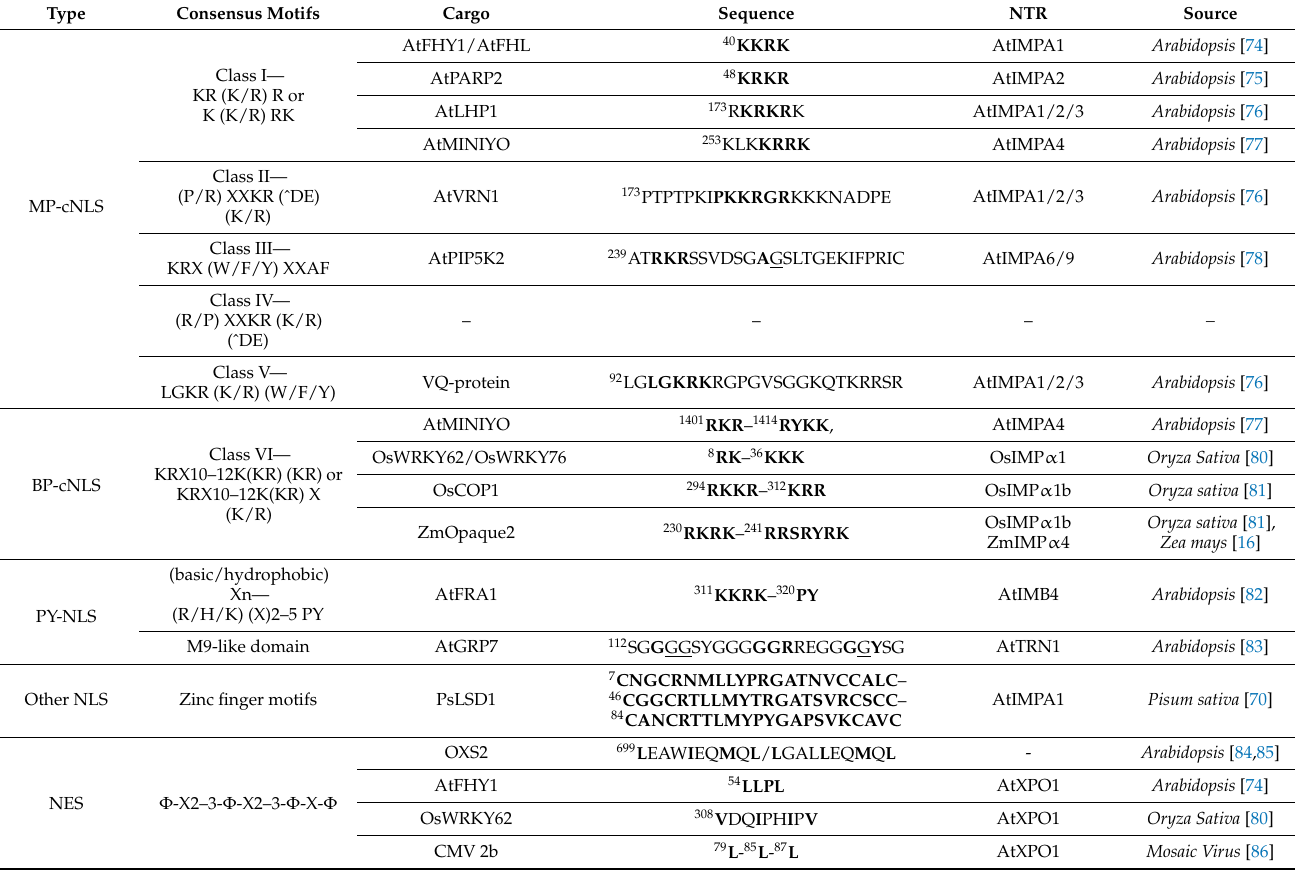
Table 2. Classification of NLSs and NESs recognized by KAPs in